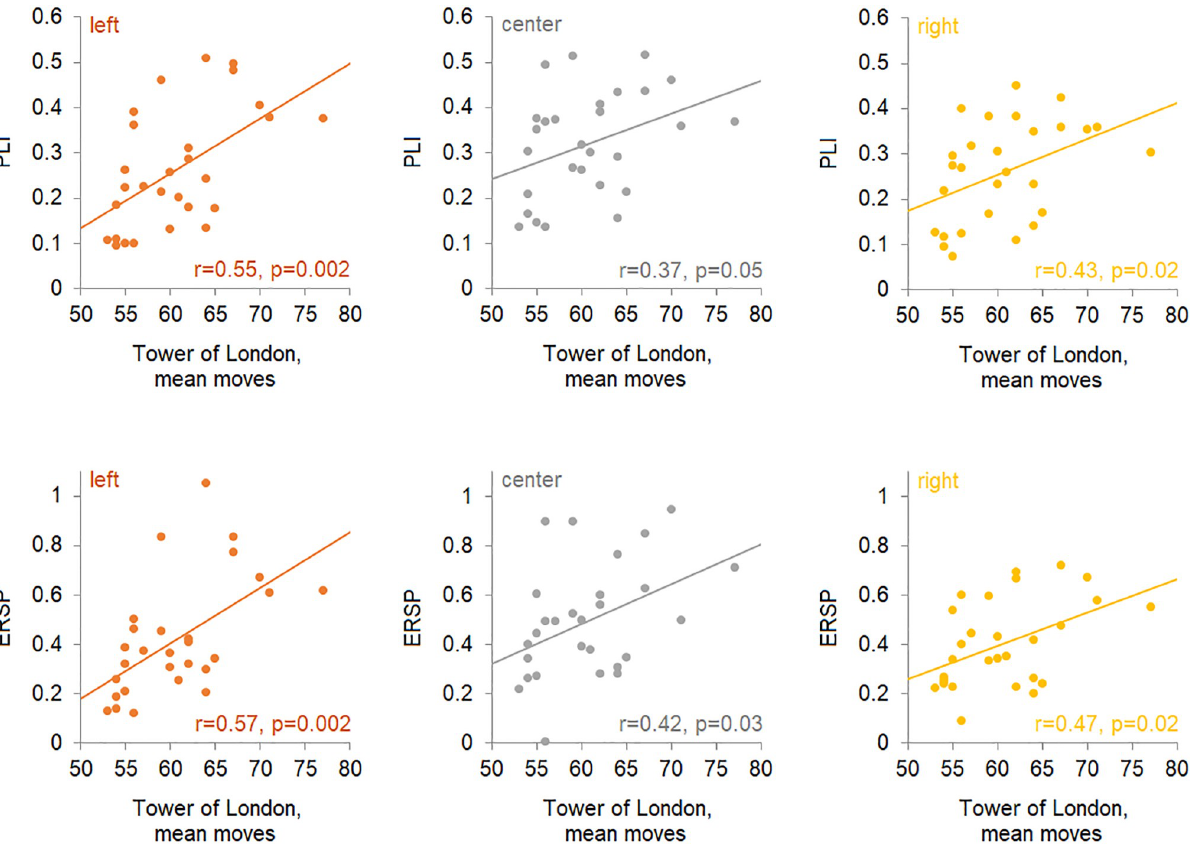
Fig 3. Scatterplots of PLIs and ERSPs against mean moves in the Tower of London Task. Plots are presented separately for the left, central and right regions.